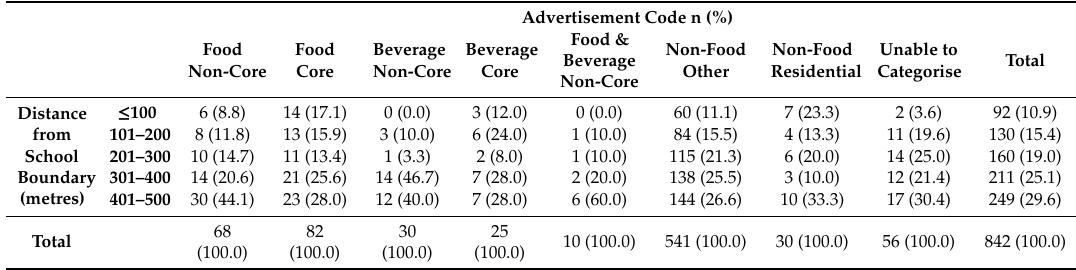
Table 4. Proportion of Advertisements by Distance from School